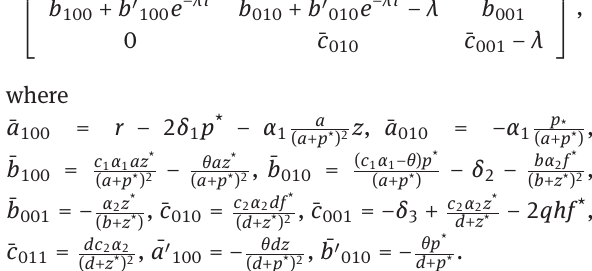
∞) for each k ≥ 1, where ¯ τ ≤ τ